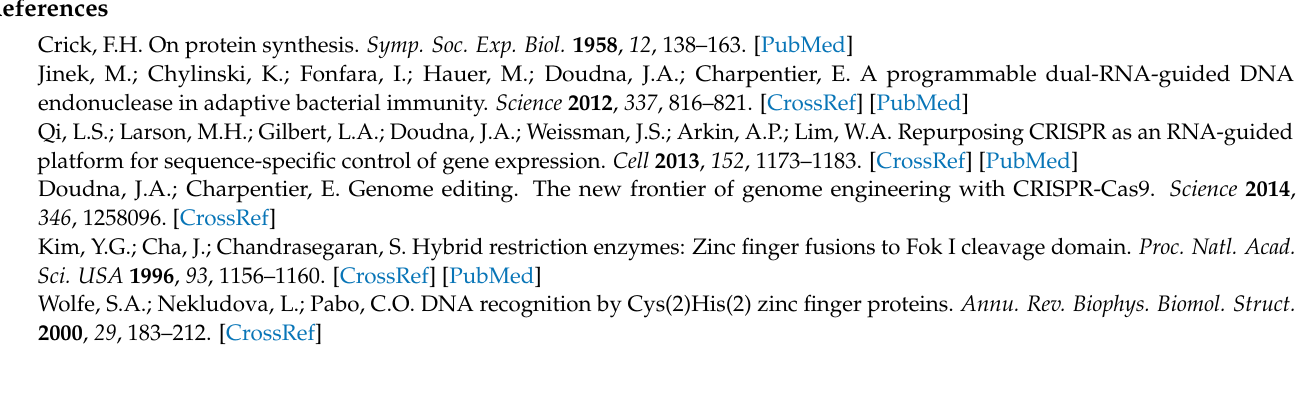
Figure 15. Applications of PNA Invasion to ( a ) functional regulation of enzymes and ( b ) DNA cleav- age.